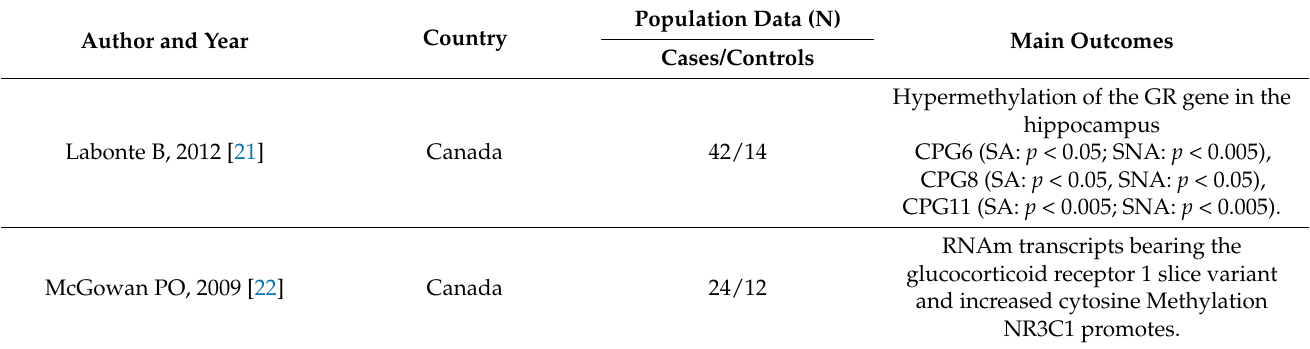
Table 2. Characteristics of the studies included in the systematic